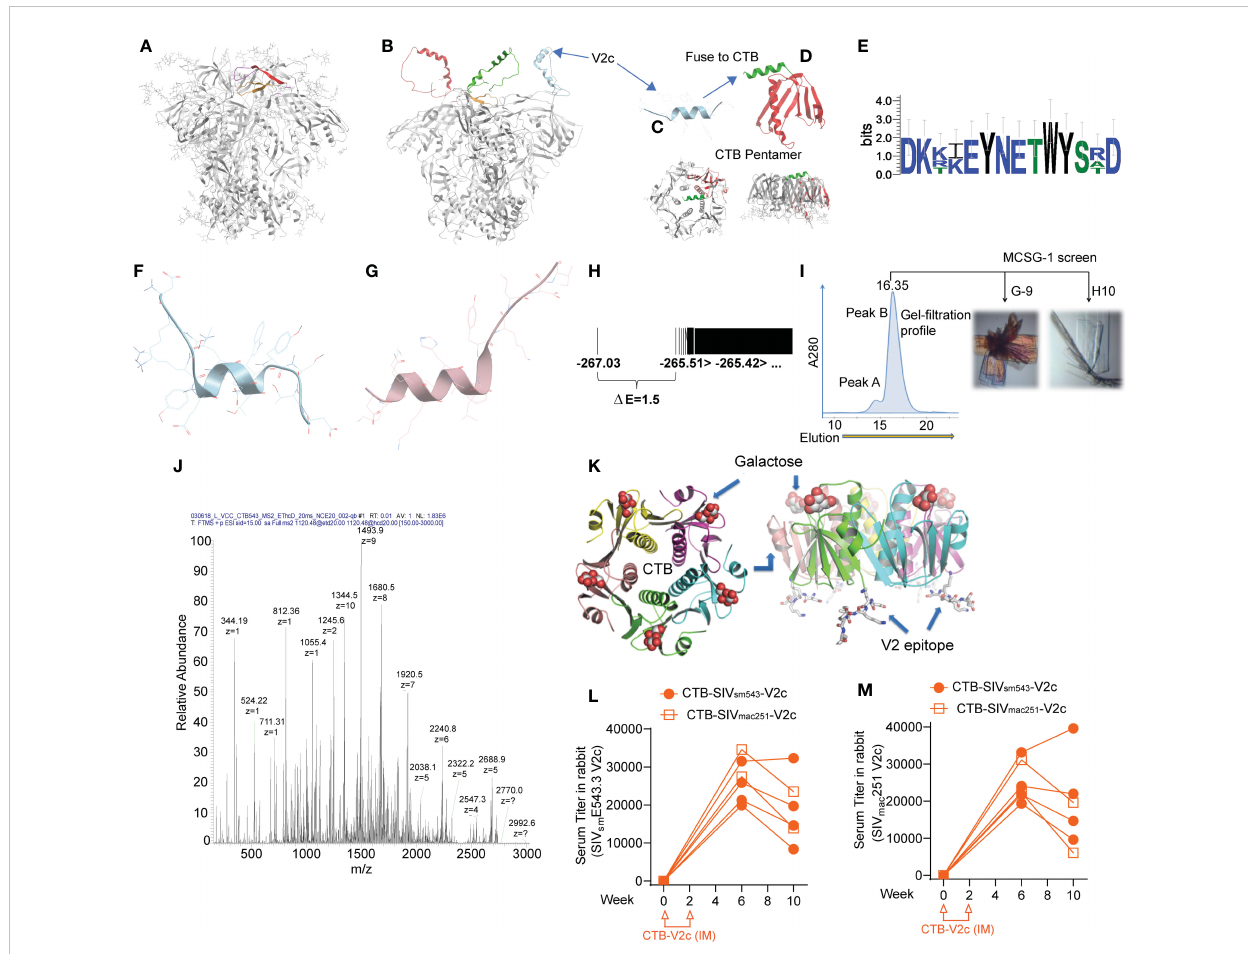
FIGURE 1 Incorporation of isolated SIV V2 a -helix peptide (V2c) in scaffolded cholera toxin B to generate vaccine. (A) Side view of HIV trimeric viral spike structure in complex with apically targeted, broadly neutralizing antibody (PDB 4tvp). V3 loop colored orange, V2b/c epitope colored red. (B) Model of HIV viral spike with its V1/V2 domain in the a -helical form exposed at the extreme apex of the viral spike that is observed in its complex with the non-neutralizing mAb CAP228-16H (PDB 6FY1). (C, D) Design of CTB-V2c: the isolated V2c peptide fragment fused with the cholera toxin B subunit (red ribbon). Crystallography con fi rmed that the subunit still formed a stable pentamer, with preserved GM1-ganglioside and mucosal-targeting sites. (E) Weblogo of sequence variation in V2c region in SIV mac251 , SIV mac239 , SIV smE660 and SIV smE543 . (F) Lowest energy conformation from full ab initio prediction of V2c from SIV mac251 . (G) V2c from HIV A244 in complex with mAb CH58 (from Liao et al., 2013). (H) Energy spectrum of conformations from V2c ab initio folding, showing energy gap of 1.5, indicative of a moderately rigid a -helix. (I) Gel fi ltration pro fi le of CTB-V2c-SIV, crystallization screens were conducted using the peak sample and resulted in two crystal forms. (J) LC/MS con fi rming composition of puri fi ed CTB-V2c-SIV. (K) 2.4 A structural model of CTB-V2c-SIV based on crystallographic electron density from crystal in fi gure. (I, L) Serum V2c-speci fi c IgG titer